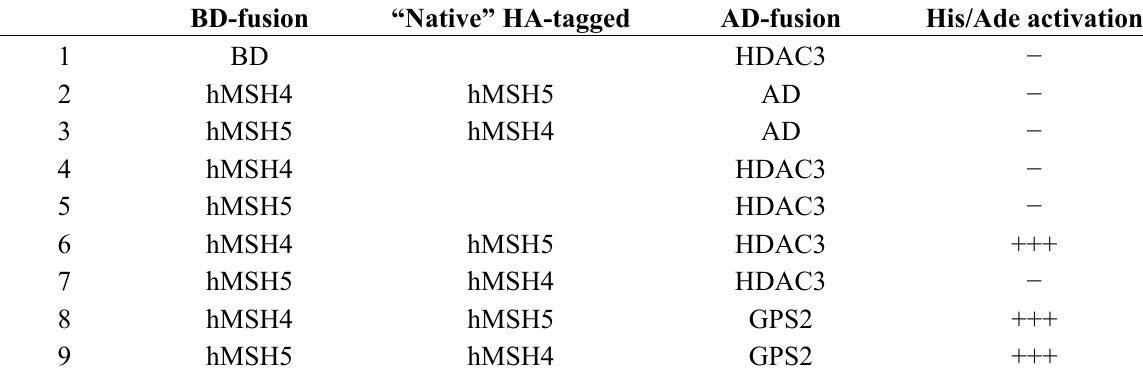
Table 1. Yeast three-hybrid analysis of hMSH4-hMSH5 and HDAC3 interaction. BD-fusion “Native” HA-tagged AD-fusion His/Ade